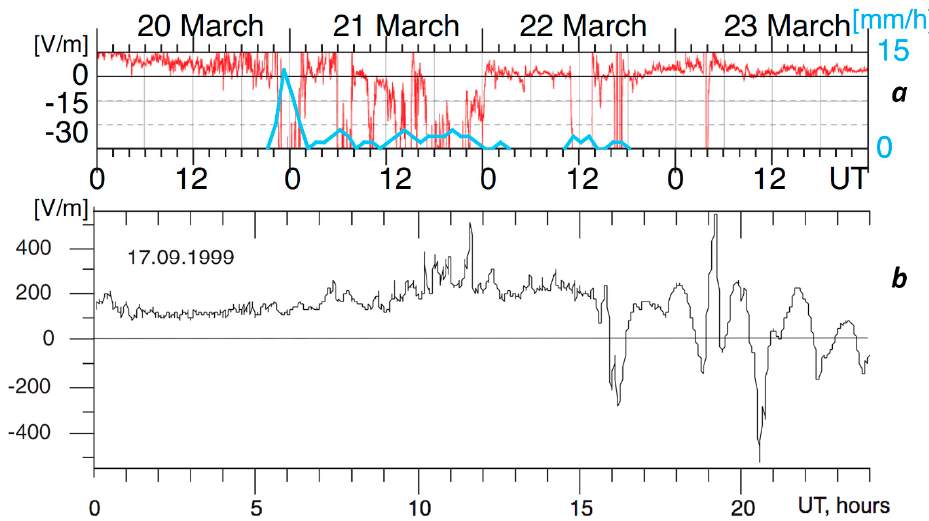
Figure 2. ( a )Atmospheric electric field (red) measured at the Kakioka geophysical observatory (Japan) over 20–23 March 2011 (Yamauchi et al., 2012) [23]; ( b )Atmospheric electric field measured at the Paratunka geophysical observatory (Kam- chatka peninsula) on 17 September 1999, one day before the M6 earthquake at Kamchatka (Mikhailov et al., 2004) [24]. (Japan) over 20–23 March 2011 (Yamauchi et al., 2012) [23]; ( b ) Atmospheric electric field